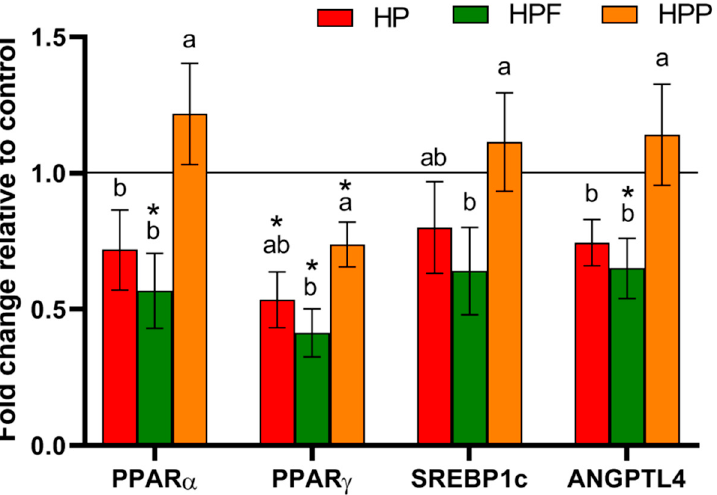
Figure 1. mRNA expression of selected factors associated with lipid metabolism in the livers of rats fed experimental diets. The values are the means ± SEMs. a,b Mean values not sharing the same superscript letter (a or b) are different at p < 0.05 in a post hoc test (Dunn’s test). * Mean values are significantly different in comparison to the control H group, fed a high-fat diet. HP, control high-fat diet enriched with raspberry polyphenol extract; HPF, control high-fat diet enriched with raspberry polyphenol extract and fructo-oligosaccharides; HPP, control high-fat diet enriched with raspberry polyphenol extract and pectin. PPAR α , peroxisome proliferator-activated receptor alpha; PPAR γ , peroxisome proliferator-activated receptor gamma; SREBP-1c, sterol regulatory element-binding protein 1; ANGPTL4, angiopoietin-like